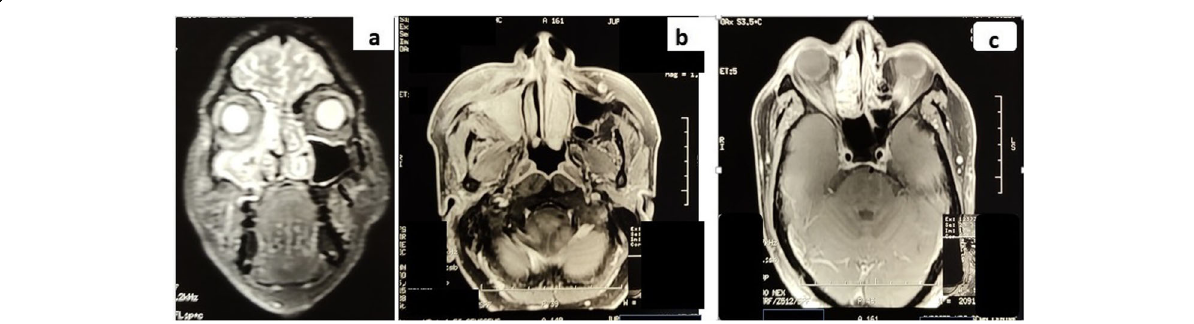
Fig. 4 CEMRI showing post RT changes in a sagittal view and b , c axial view showing diffuse mucosal thickening without any evidence of enhancing solid